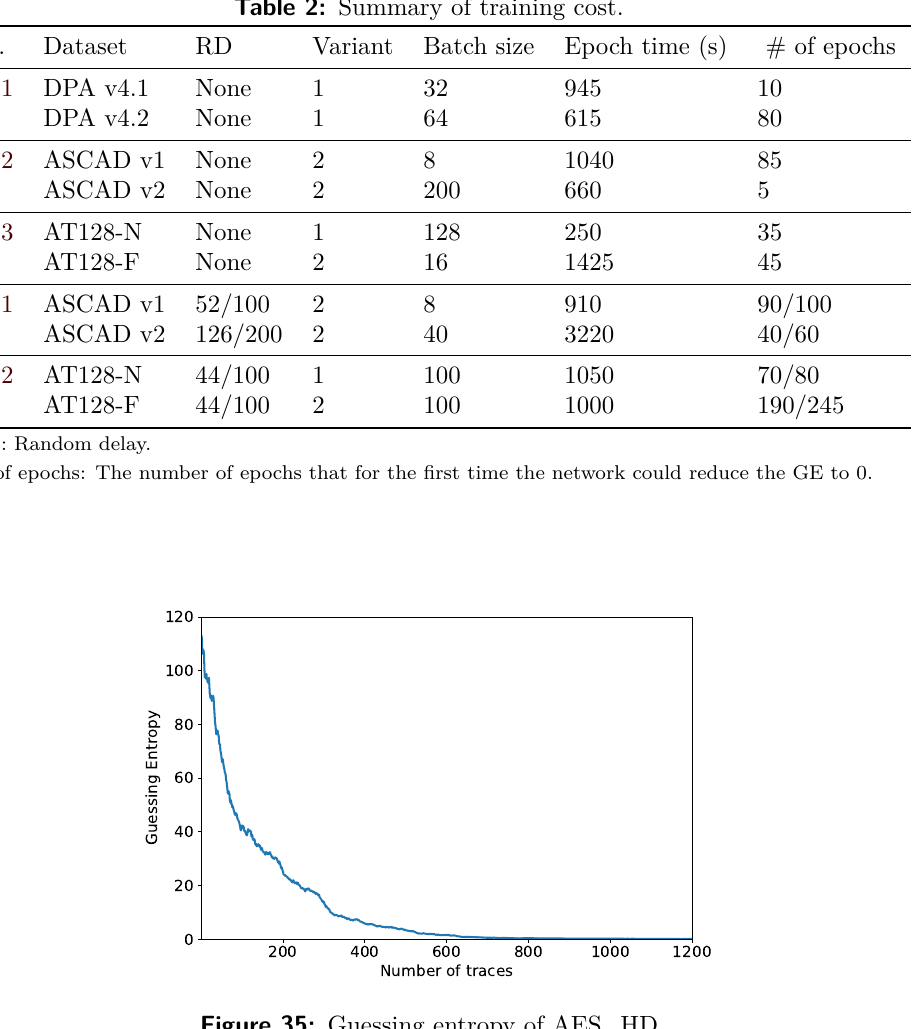
Figure 35: Guessing entropy of AES_HD